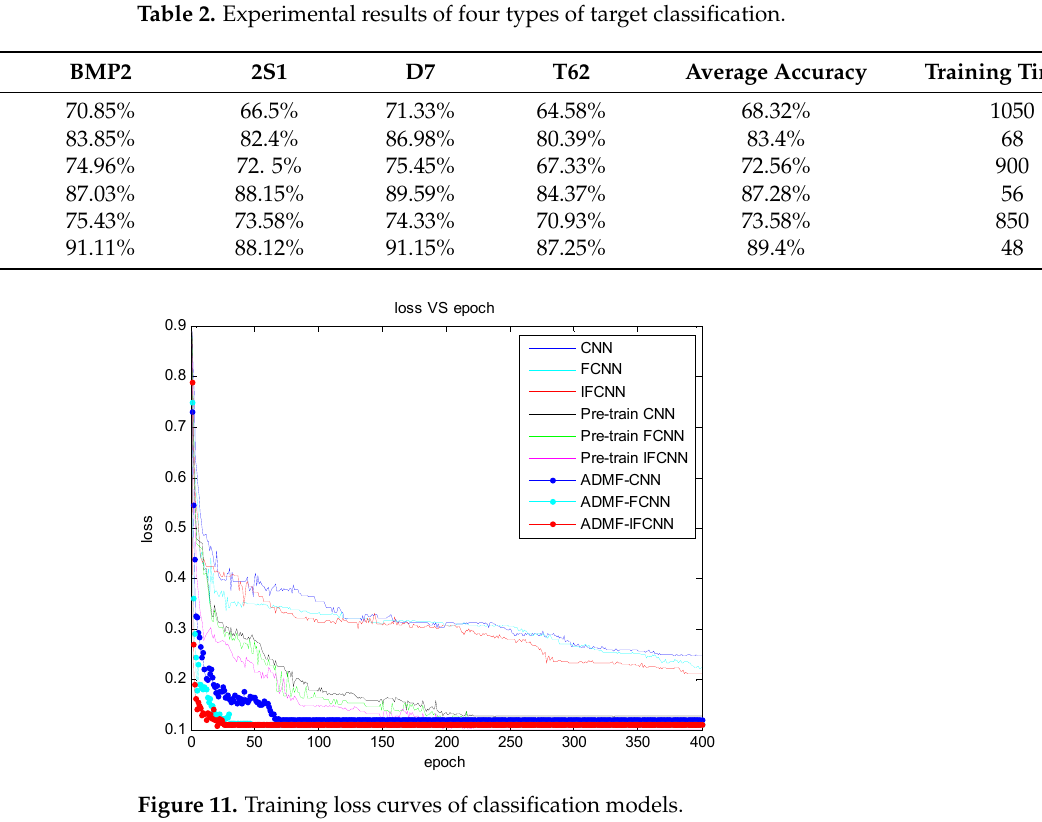
Figure 12. The total time consumption of the pre-training and training process. Table 2 shows the target recognition accuracy and training convergence time of the three networks through the process of pre-training and no pre-training. Figure 11 records each training convergence process of the three networks, namely the direct training pro- cess, pre-training process, and network training process after pre-training of CNN, FCNN, and IFCNN. Figure 12 shows the network time characteristic of each training convergence process. From Table 2, we can see the testing accuracy and the average testing accuracy of the four-target. By comparing, the test accuracies of the three networks have been improved after the pre-training process, from the average testing accuracy data, the difference be- tween the network pre-training and no pre-training results is close to 15%. In addition, the training convergence time of every network through pre-training has been greatly re- duced; as shown in Figure 11, all three networks after pre-training reach convergence in about 60 epochs during the training process, while all three networks converge in about 210 epochs during the pre-training process. At last, all three networks still do not converge stably in 400 epochs during the direct training, which verifies the effectiveness of the pr- training method proposed. In order to directly analyze the effectiveness of the pre-training method based on the ADMF proposed, we carry out time consumption statistics of the pre-training and training